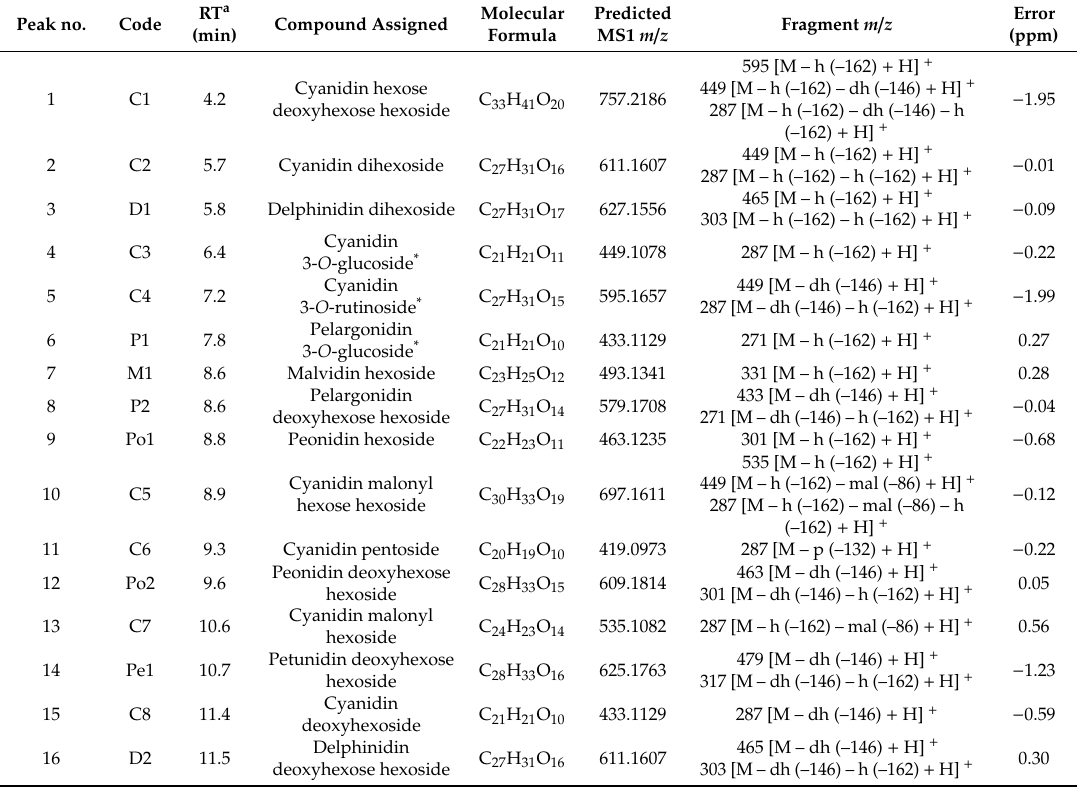
Table 4. Identified anthocyanins in mulberry fruits using UHPLC-(ESI)-qTOF. Peak